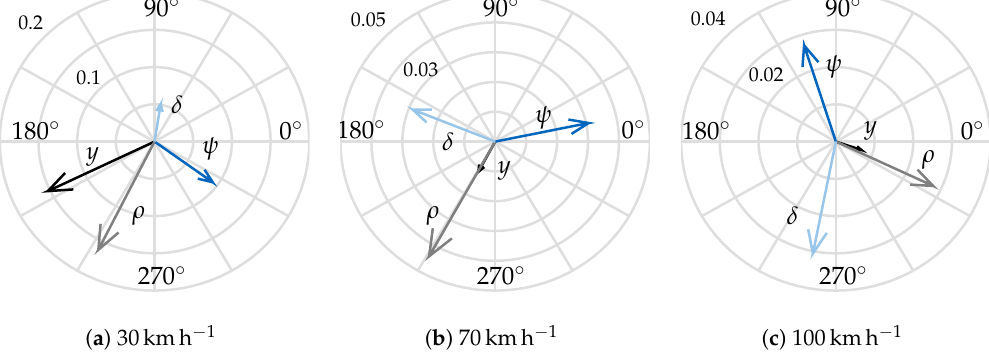
Figure 14. Compass plot of the weave eigenvector at different